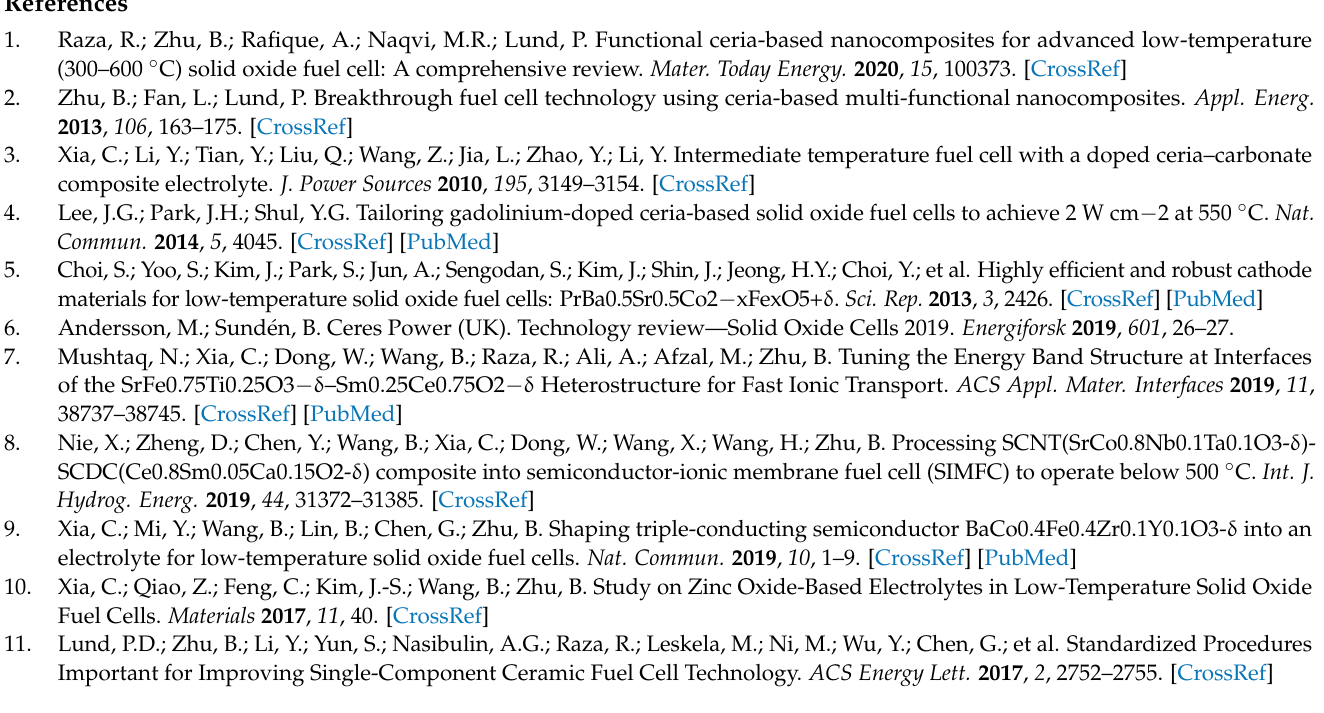
Figure S3: Full I-V-P profile of cells by sweeping on different time intervals (a) CeO2; (b) 4SDC-SnO2